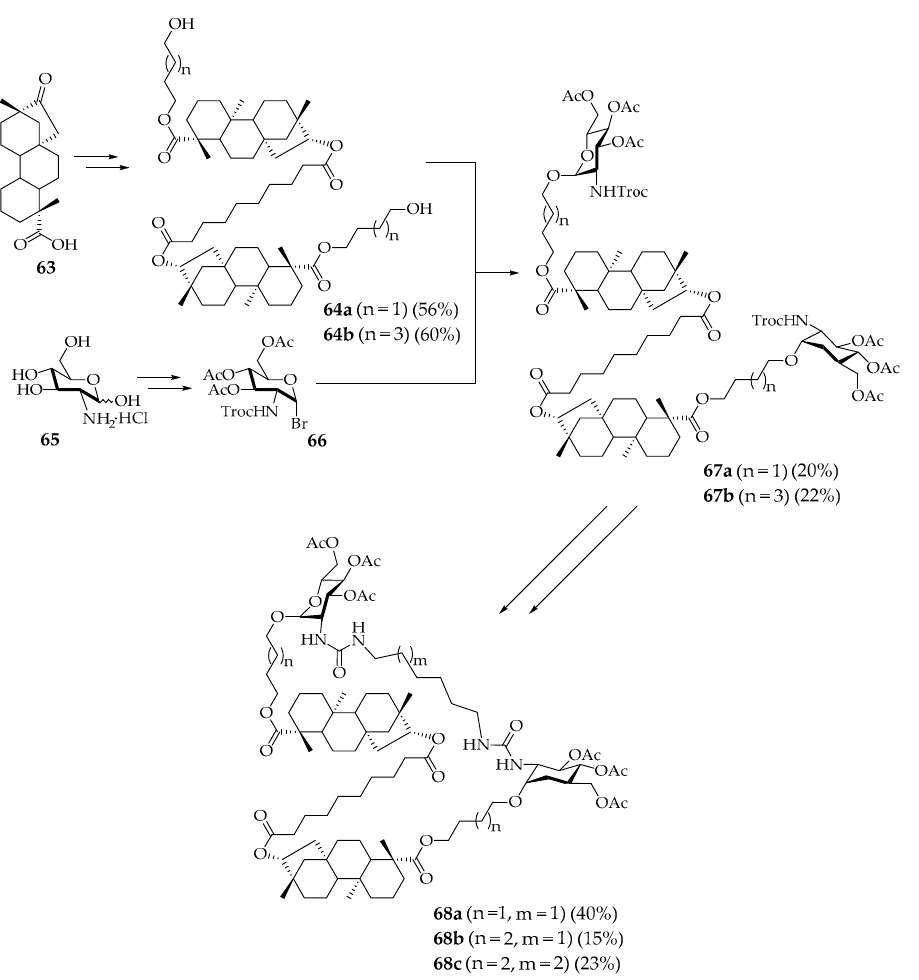
Scheme 10. Synthesis of macrocyclic glycoterpenoids 68a − c .